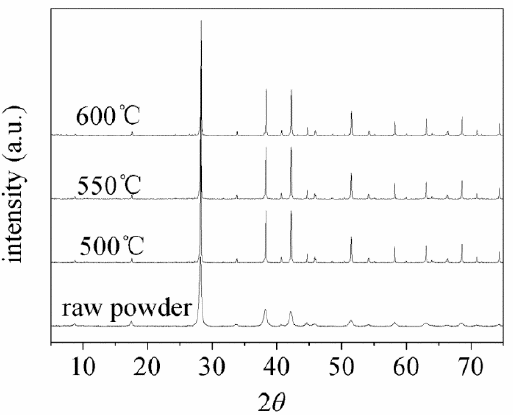
Figure 1. XRD diffraction patterns of (Bi 0.48 Sb 1.52 )Te 3 raw powder and its thick films.